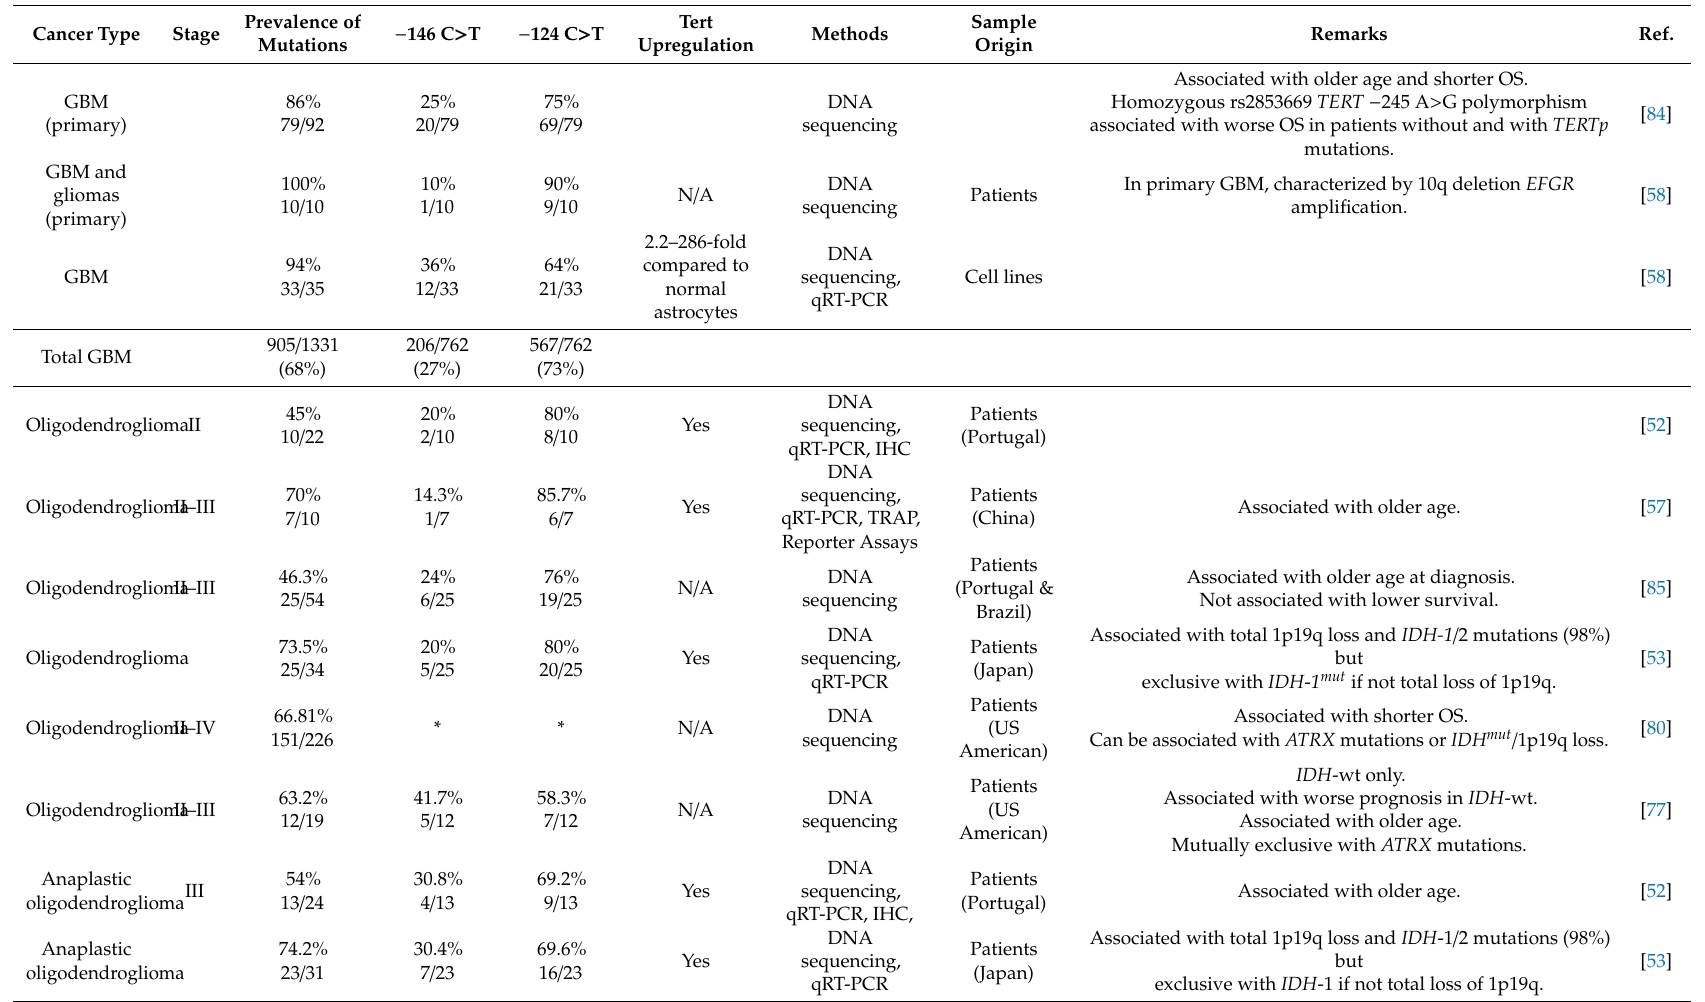
Associated with total 1p19q loss and IDH -1 / 2 mutations (98%) Patients but (Japan) exclusive with IDH -1 if not total loss of